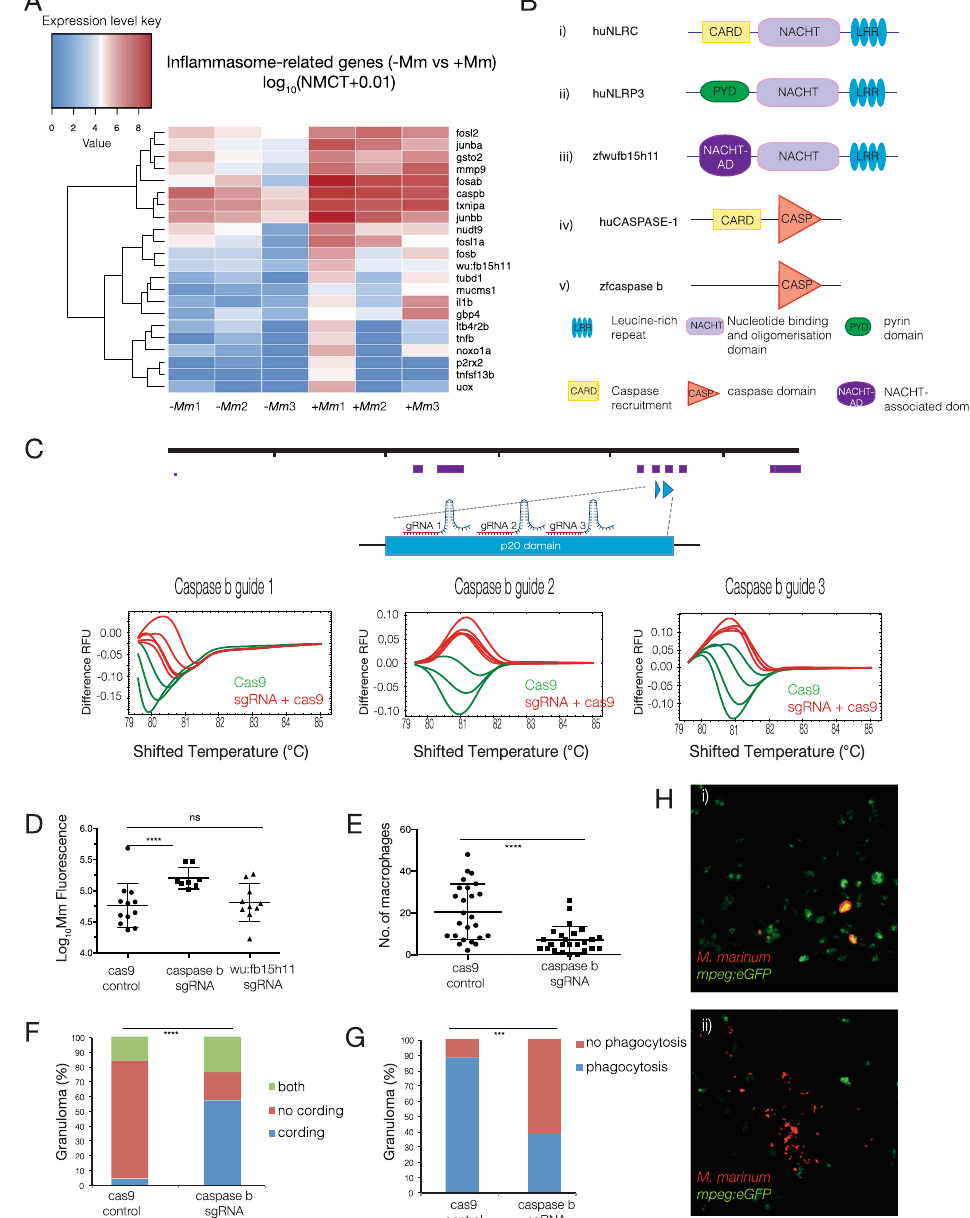
Figure 4. Neutrophils mediate M . marinum killing by inflammasome-dependent mechanism. ( A ) Heatmap shows the log 10 (normalised counts (NMCT) + 0.01) of selected differentially expressed transcripts of known inflammasome components and related genes (adjusted p-value < 0.05). Red - high expression. White - medium expression. Blue - low expression. ( B ) Schematic representation of the domain organisation of huNLRP3 (i), huNLRC (ii), zfwu:fb15h11 (iii), huCaspase 1 (iv) and zfcaspase b (v). ( C ) caspase b sgRNA tests for efficiency in inducing DNA double-strand breaks. sgRNAs were injected into the 1-cell stage and genomic DNA extracted at 24 hpf. High resolution melting curves from 3–4 individual embryos injected either with Cas9 mRNA only (green) or co-injected with Cas9 mRNA and caspase b sgRNA (red) are shown. ( D – H ) For quantitative analysis of inflammasome components, embryos were injected at the one-cell stage with Cas9 mRNA or sgRNAs to caspase b or wu:fb15h11 followed by injection of M . marinum at the 32–512 cell stage. ( D ) Bacterial burden of larvae infected at 3 dpi as measured by Mm fluorescence intensity (red). Statistical significance was determined by two-tailed unpaired students t-test with Welch’s correction. For caspase b sgRNA, **** p < 0 . 0001 . ( E ) Enumeration of macrophage infiltrating M . marinum at 5 dpi. Statistical significance was determined by two- tailed unpaired students t-test with Welch’s correction ( **** p < 0 . 0001 ). ( F ) Percentage of larvae with cording phenotype at 5 dpi. Statistical significance was determined by chi-squared test ( **** p < 0 . 0001 ). ( G ) percentage of larvae where macrophages phagocytise M . marinum at 5 dpi. Statistical significance was determined by Fishers exact test ( *** p < 0 . 001 ). ( H ) Representative maximum intensity projections of larvae with cording bacteria with decreased phagocytosis in caspase b knockout embryos (i) vs non-cording controls